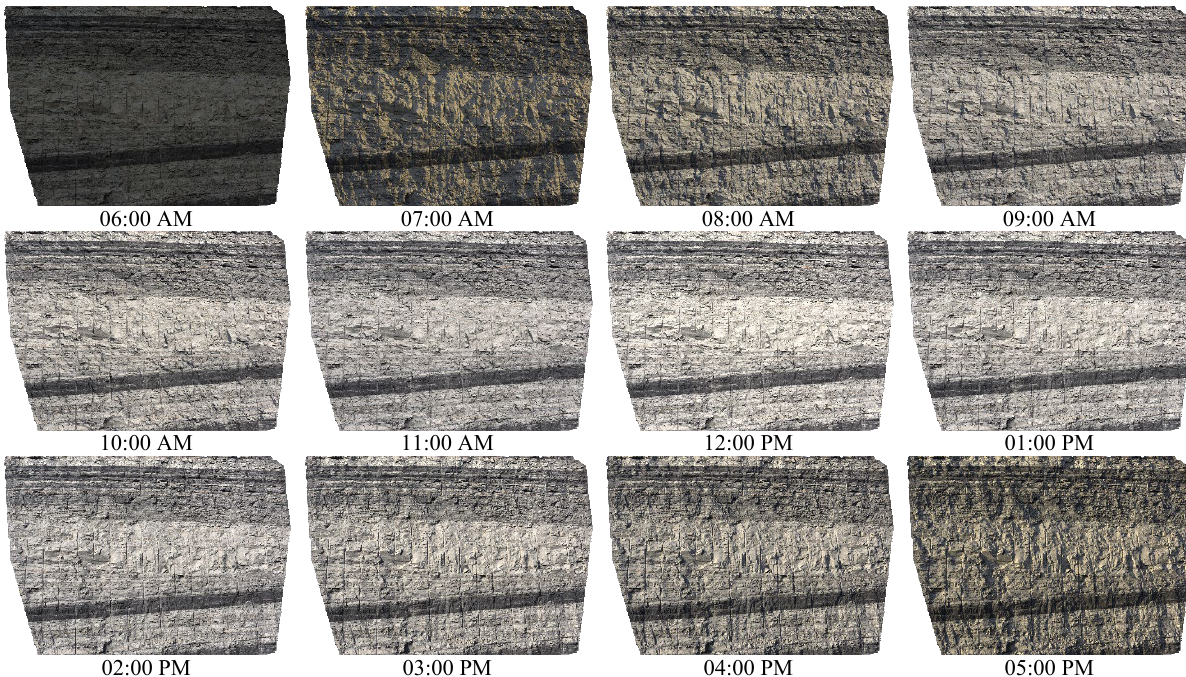
Figure 2 . Samples of images obtained by rendering the scene of the virtual simulated test site VTS at different times during the